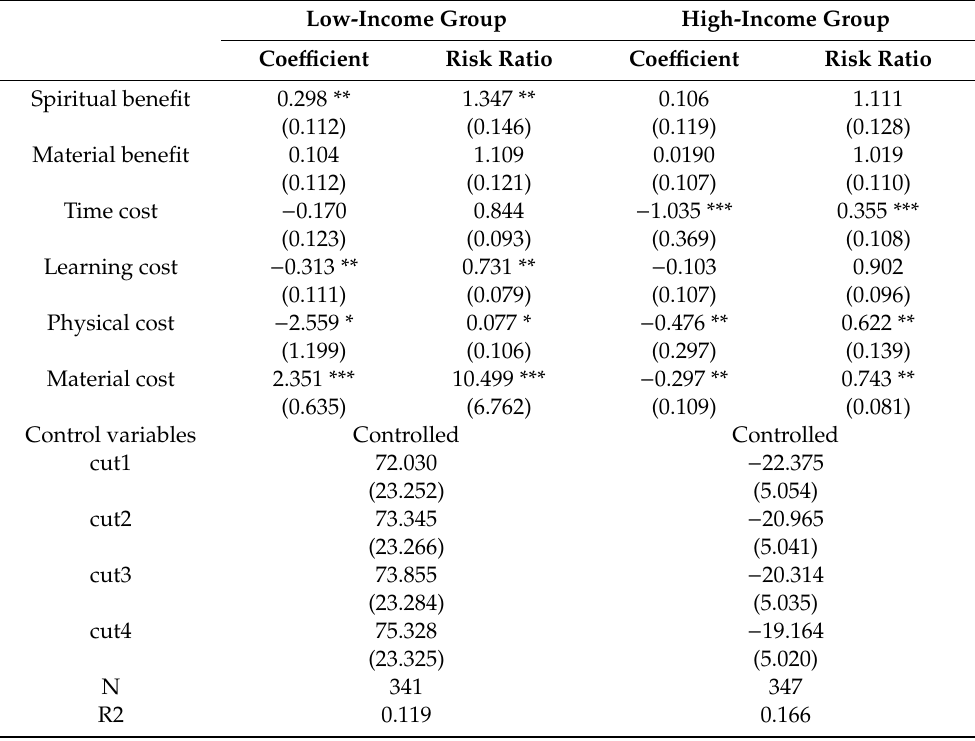
Table 5. E ff ects of perceived benefit and perceived cost of waste sorting behavior at di ff erent income